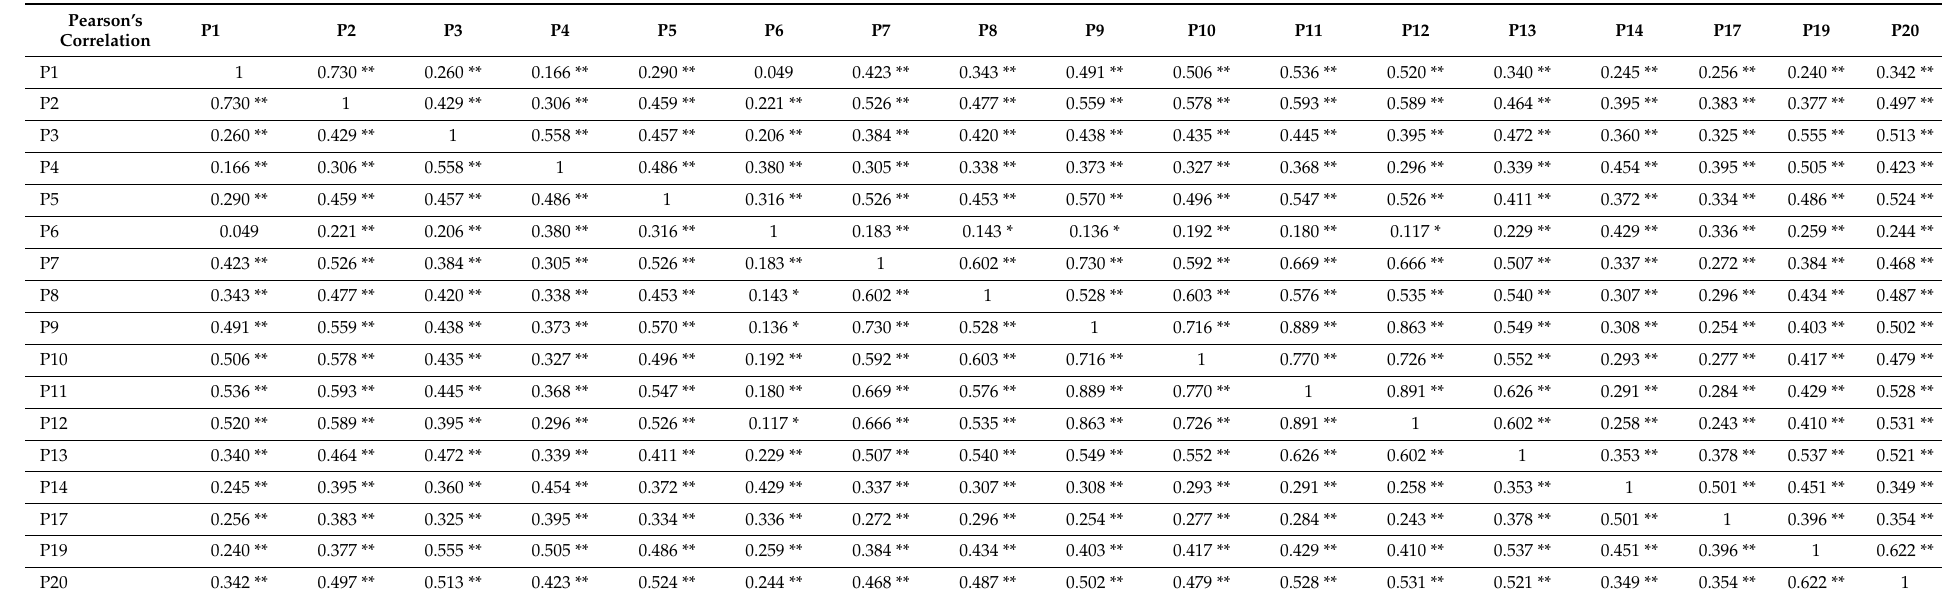
Table 3. Pearson’s correlation coefficient between input